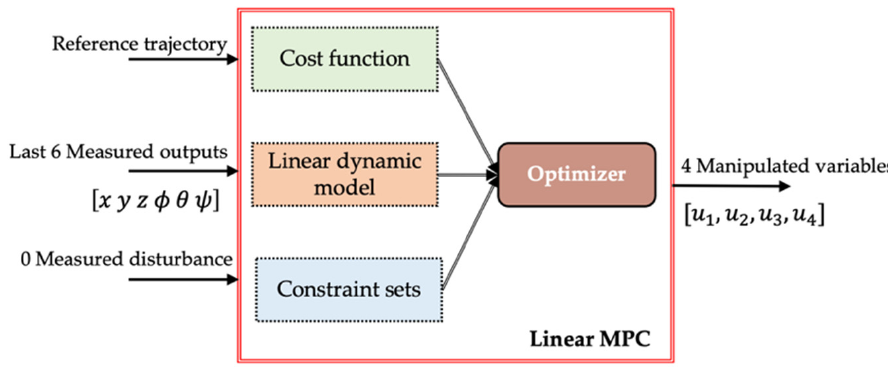
Figure 7. MPC controller inputs and outputs. Table 3. The required parameters of MPC for the Tello quad-rotor .